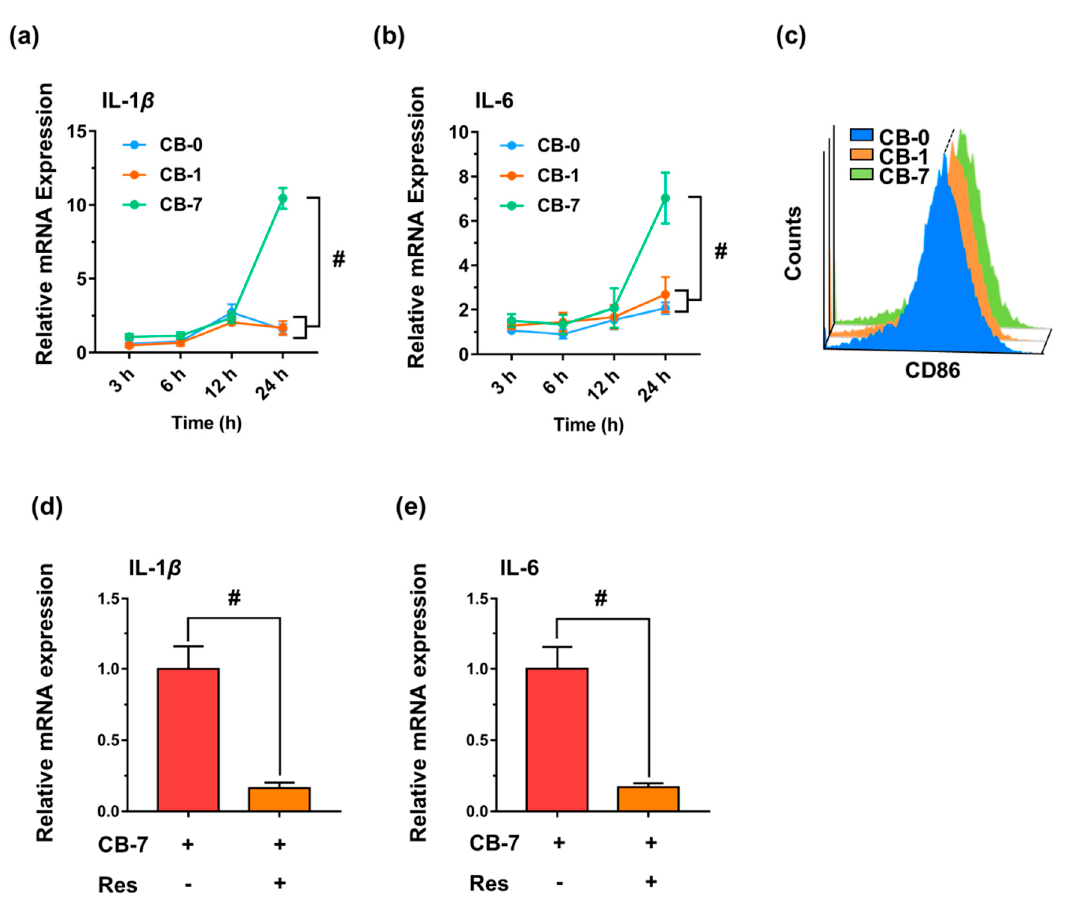
Figure 6. Inflammatory responses induced by CB particles in macrophages. ( a , b ) Gene expression levels of IL-1 β and IL-6 in J774A.1 macrophages after exposure to CB particles at different time points (10 µg/mL, n = 6) relative to the untreated control. ( c ) CD86 expression level in J774A.1 macrophages after exposure to CB particles (10 µg/mL) for 24 h, as determined by flow cytometry analysis. ( d , e ) IL-1 β and IL-6 expression levels in J774A.1 macrophages after exposure to CB particles for 24 h with or without pretreatment with the Res (at 1 µM, n = 6), as characterized by qRT-PCR analysis relative to the untreated CB-7 group. All controls are untreated groups. Statistical significance between groups: (#) p < 0.001. Abbreviations: CB, carbon black; IL, interleukin; Res, Resatorvid.